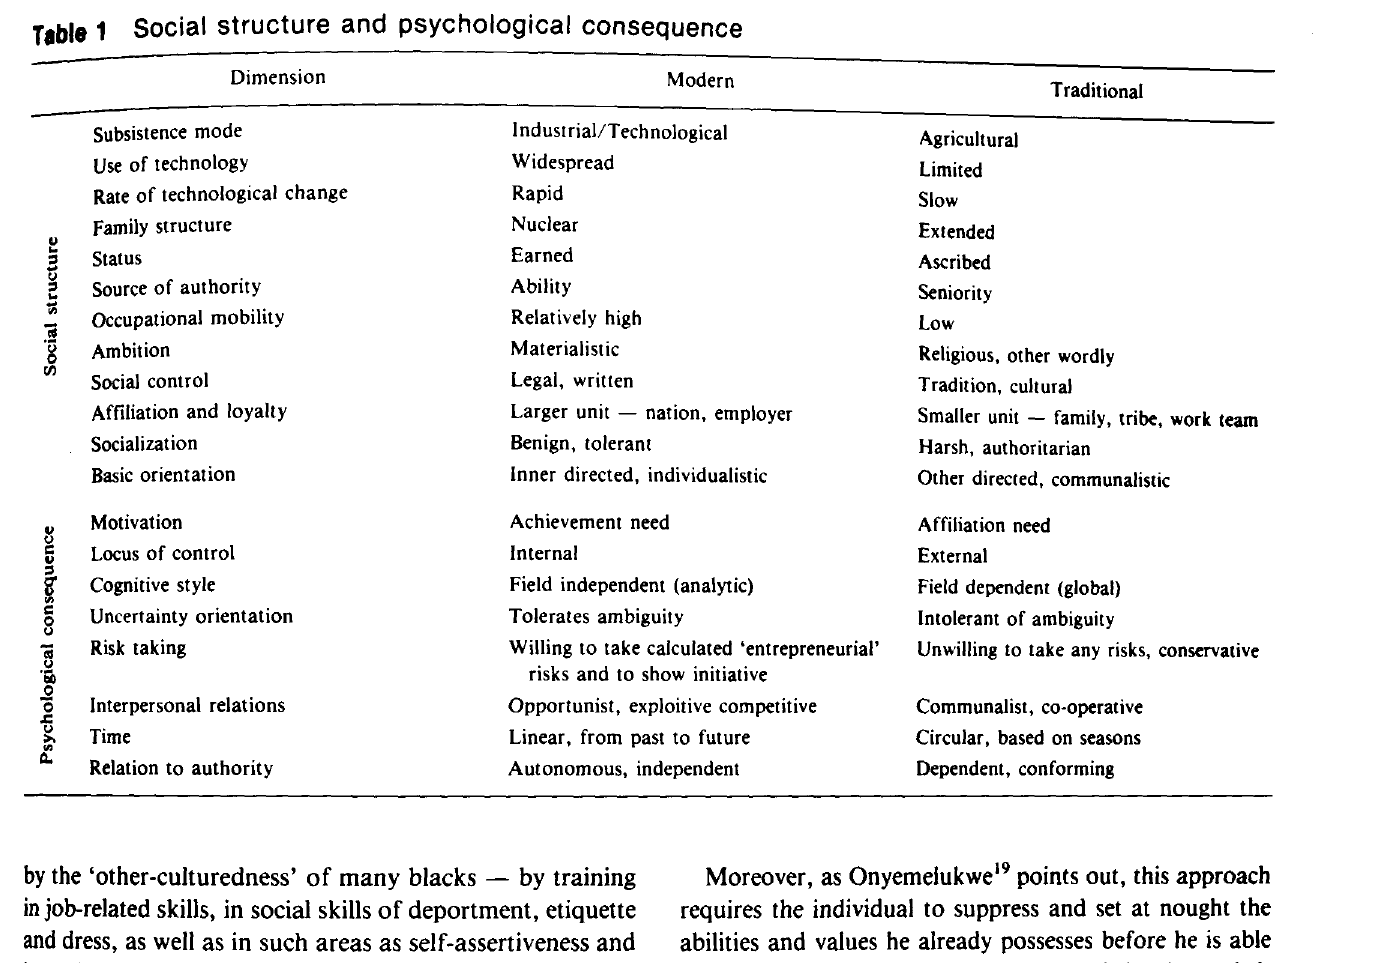
Table 1 Social structure and psychological